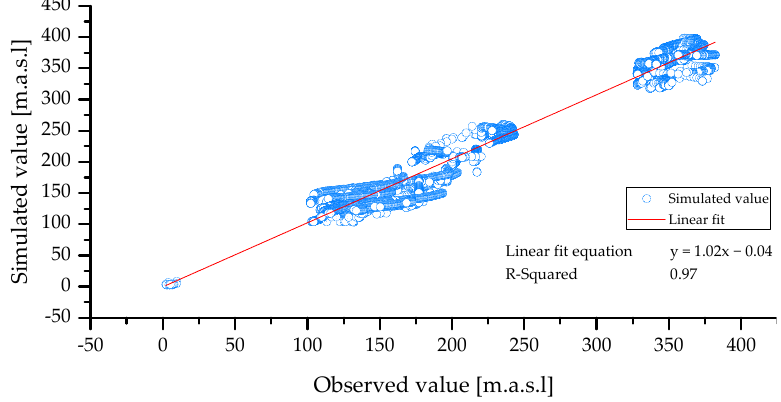
Figure 7. Observed and simulated piezometric heads of all available wells. The simulated and observed data are distributed close to the 1:1 line with R 2 being 0.97. The ranges without points correspond to the areas where there are no wells available, and thus no measuring of piezometric heads.